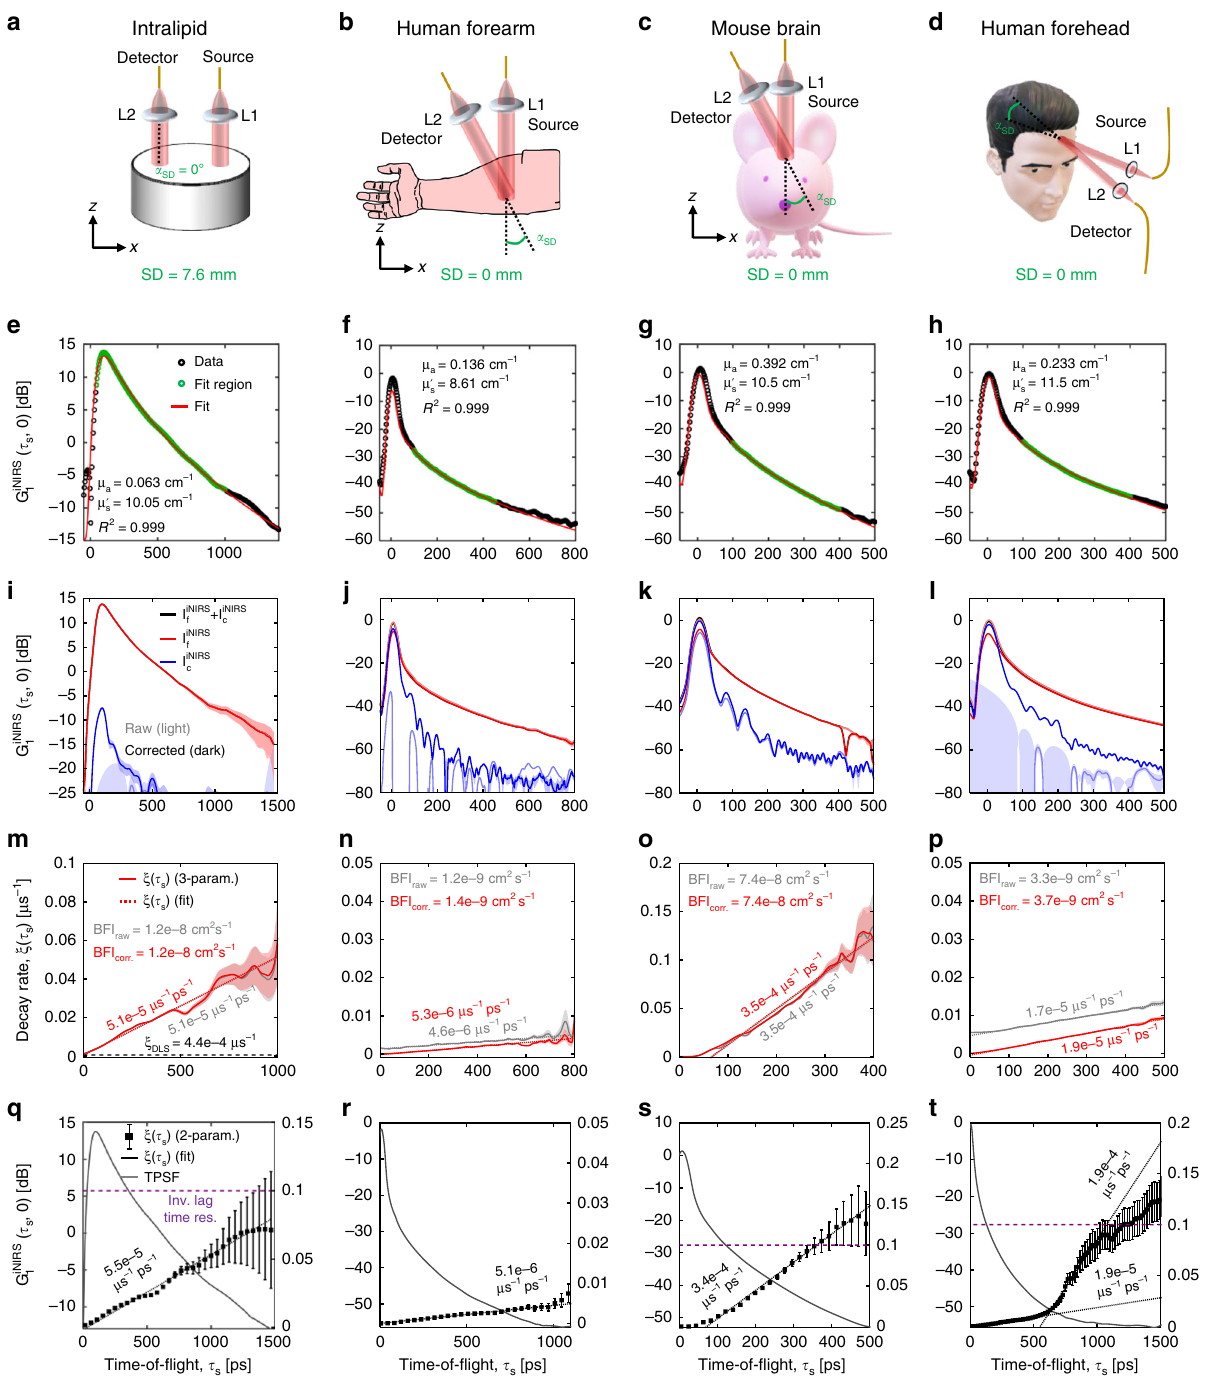
Fig. 3 Enabled by motion correction, iNIRS quanti fi es TOF-resolved dynamics in human tissues. a – d Non-contact illumination and detection geometry for phantom, mouse, and human measurements. iNIRS, like TD-NIRS, measures temporal point spread functions (TPSFs) which can be fi tted with diffusion theory to extract optical properties (absorption and reduced scattering coef fi cients, μ and μ 0 s , respectively). e – h Exemplary TPSFs, fi tting regions, diffusion a theory fi ts, and extracted optical properties for each respective medium are shown. TOF-resolved iNIRS fi eld autocorrelations can be fi tted with a 3- parameter model (two amplitudes, one decay rate), Eq. (7), to yield amplitude distributions ( i – l ) and decay rates ( m – p ). In vivo, the phase correction procedure (Fig. 2) enhances the static component, likely scattering from extravascular tissue, and reduces the dynamic component decay rate at early TOFs, improving overall agreement with DWS theory. Importantly, the DWS fi ts (dashed lines) intercept closer to zero TOF: − 9.8 ps (raw) to − 8.8 ps (corrected) in Intralipid, − 280.6 ps (raw) to 30.5 ps (corrected) in the forearm, 59.7 ps (raw) to 57.8 ps (corrected) in the mouse brain, − 287.9 ps (raw) to 16.1 ps (corrected) in the human forehead. q – t TOF-dependent averaging enables measurements at longer TOFs; the inverse of the iNIRS lag time resolution (10 μ s) is shown as a dotted violet line. All shaded regions and error bars represent 95% con fi dence